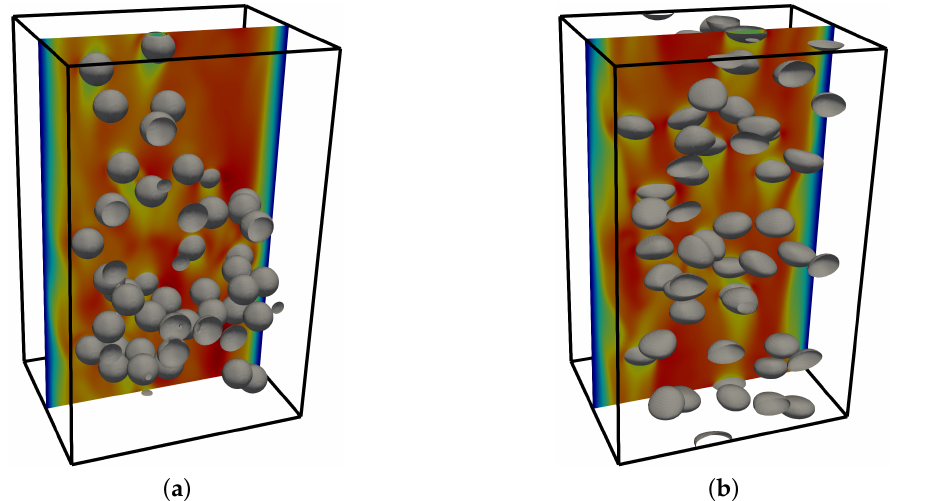
Figure 15. Isosurfaces for volume fraction f = 0.5 (gray) and wall-normal slice of the velocity magnitude on the mid-plane. ( a ) Setup with n = 1 and Eo = 0.3125; ( b ) setup with n = 1 and Eo = 3.75. It is worth noting that some bubbles intersect with the periodic boundaries, which should not be confused with a concave surface